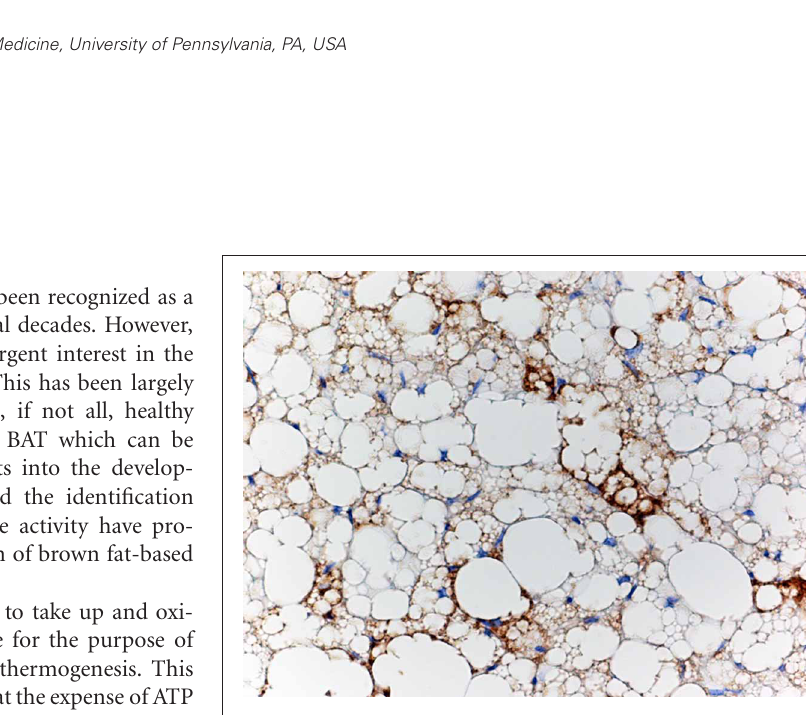
FIGURE 1 | Brown adipose tissue. Immunohistochemical staining of Ucp1 expression in brown adipose tissue showing a mixture of large and small